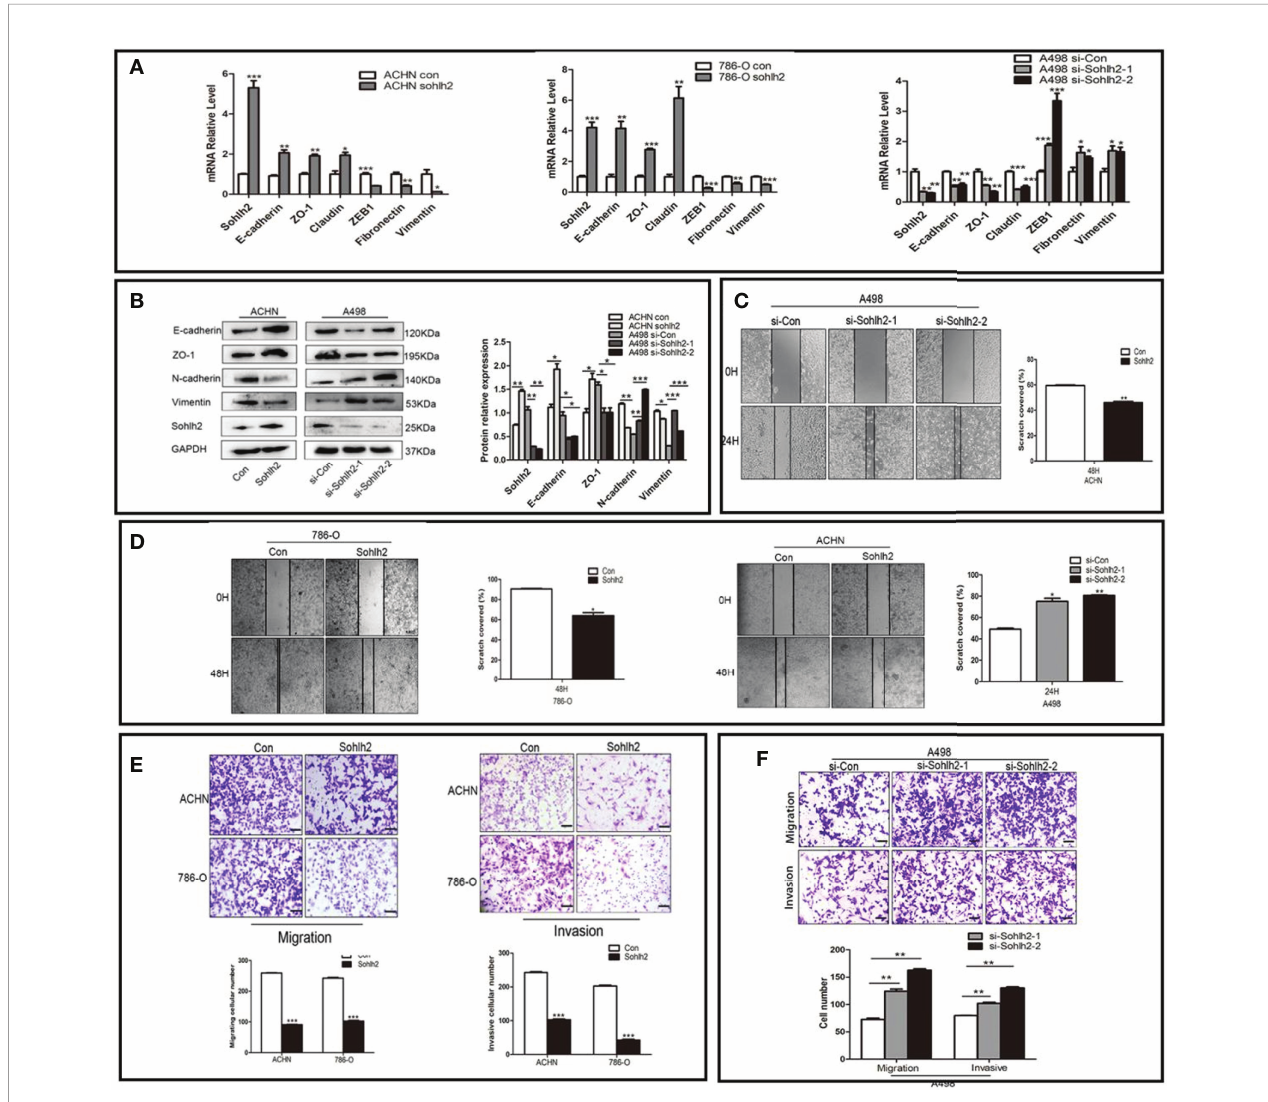
FIGURE 3 | Sohlh2 represses capacities of the EMT, migration, and invasion in RCC cells. (A, B) The results of expression of epithelial and mesenchymal cell markers by qPCR and Western blotting. (C, D) The results of the wounding healing assay in the Sohlh2 knockdown group and Sohlh2 overexpression group. (E) The results of the transwell migration assay and matrigel invasion assay in the Sohlh2 overexpression group. (F) The passing through a number of RCC cells in the Sohlh2 knockdown group. EMT, epithelial – mesenchymal transition; RCC, renal cell carcinoma. *P < 0.05; **P < 0.001; ***P <